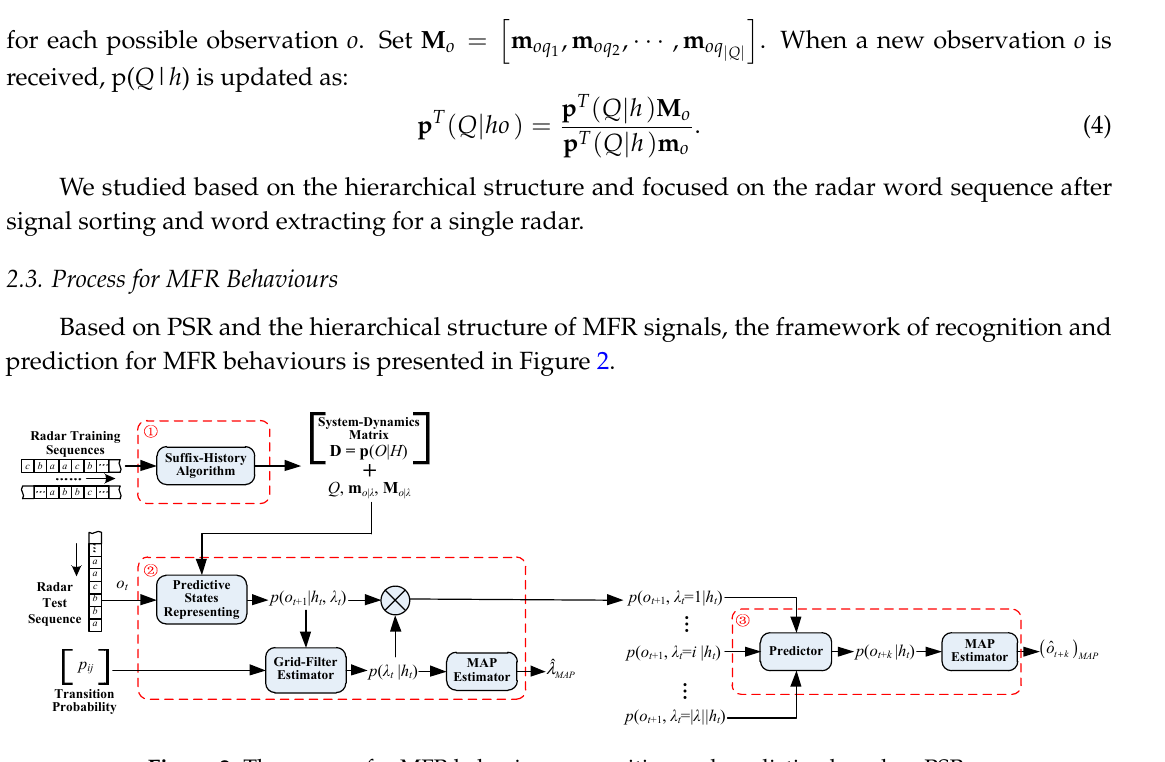
Figure 2. The process for MFR behaviour recognition and prediction based on PSR.